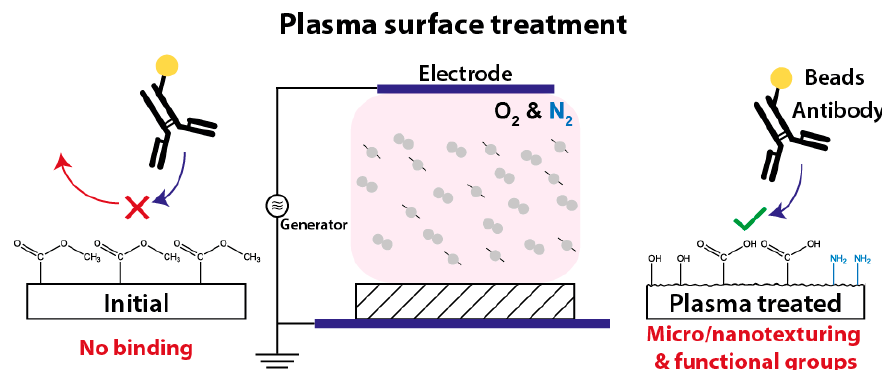
Figure 1. Plasma treatment of polymers results in the texturing of their surface in micro/nano range and generates functional surface groups which again facilitates the linker-free (physical and covalent) immobilization of biomolecules.